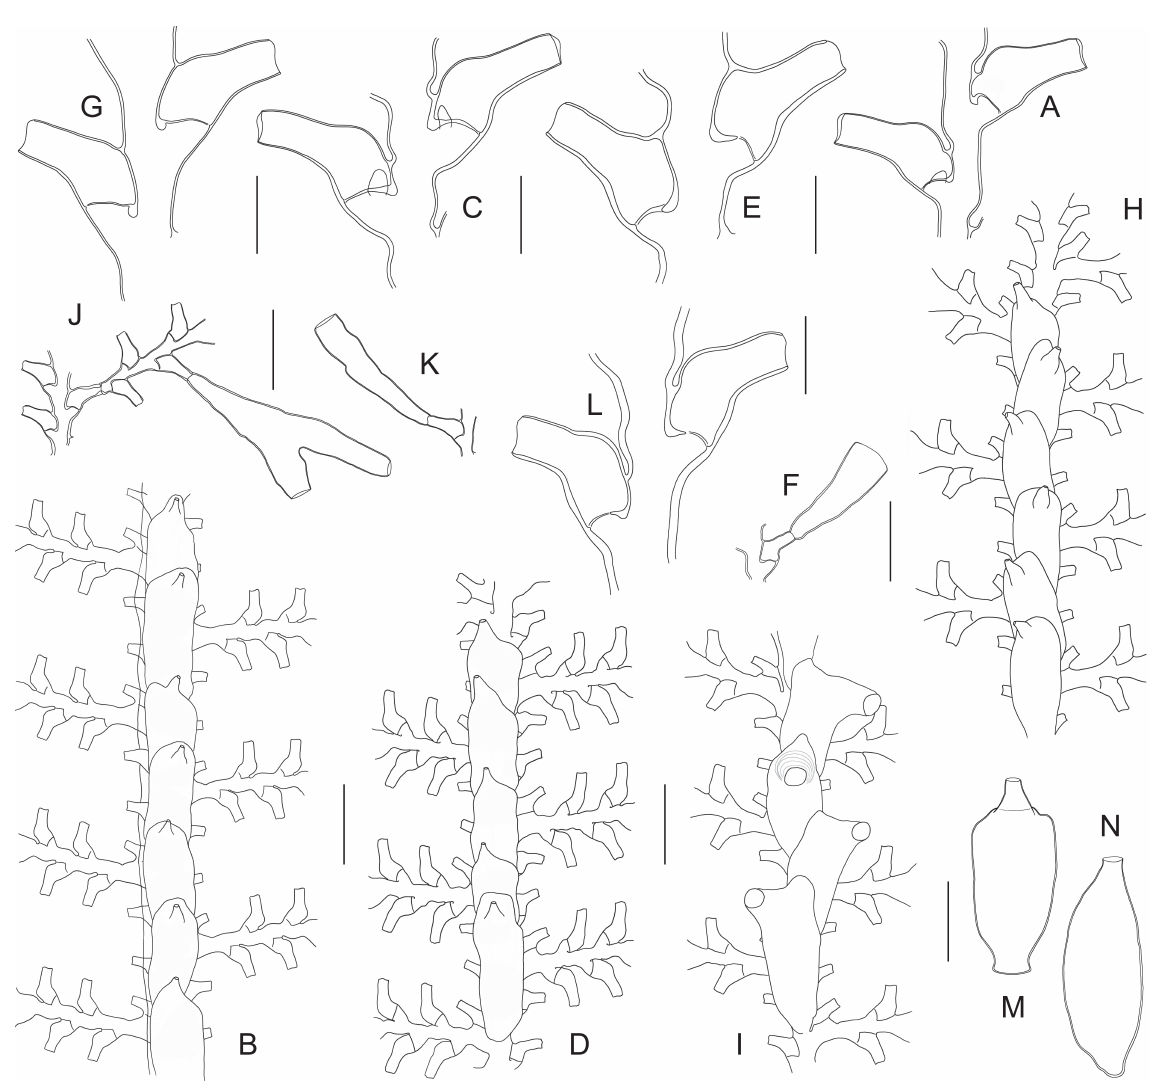
Fig. 3. ― A–B . Gonaxia amphorifera Vervoort, 1993 (SMIB6, Stn. DW127). A . Two